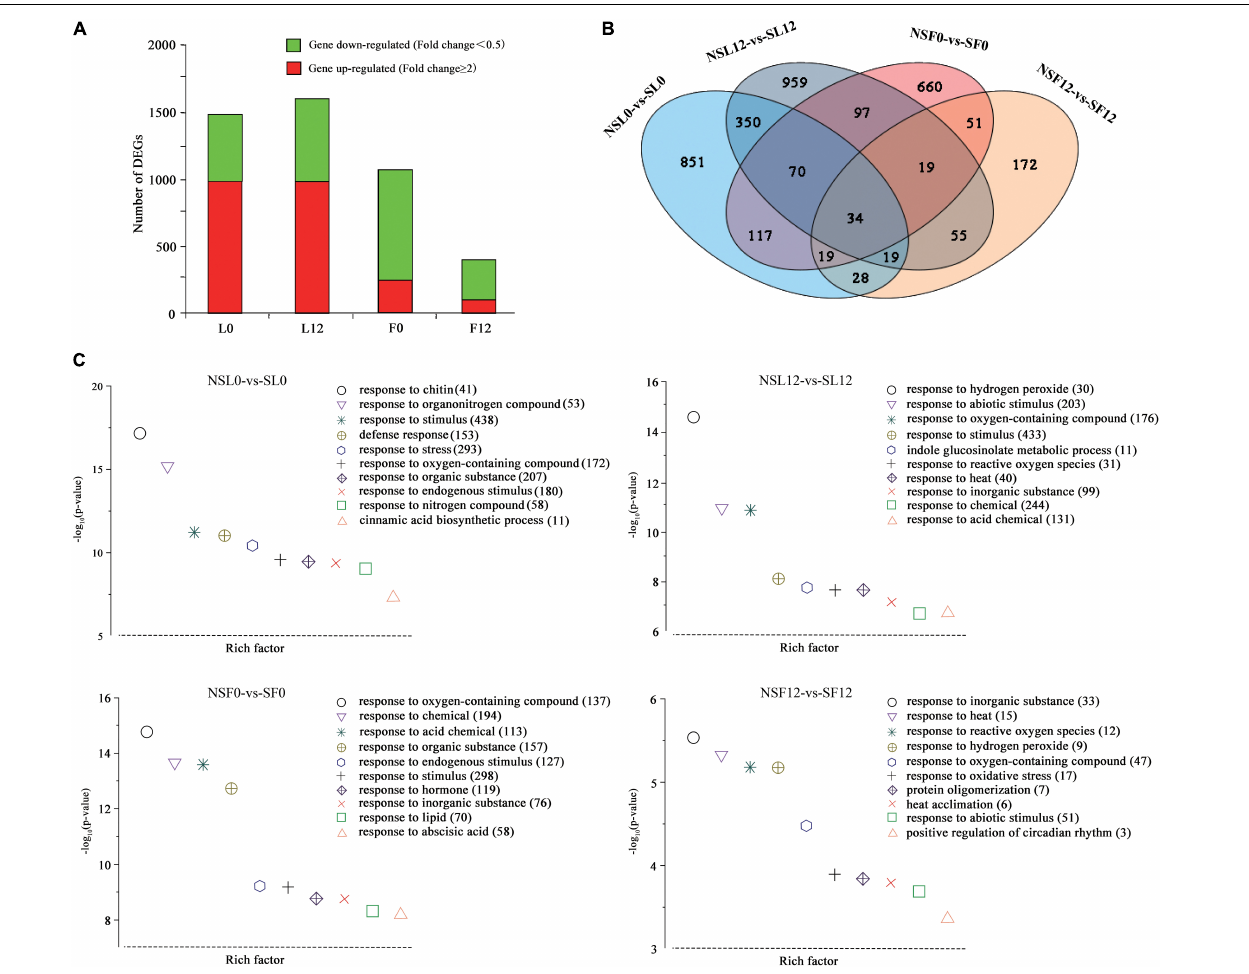
FIGURE 3 | Overview of cucumber transcriptome responses to S fumigation. (A) The number of individual transcripts significantly upregulated or downregulated at L0, L12, F0, and F12. (B) Venn diagram illustrating the number of differentially expressed genes (DEGs) upregulated or downregulated by S fumigation at L0, L12, F0, and F12. (C) Gene ontology (GO) enrichment analysis of DEGs in the cucumber transcriptome at L0, L12, F0, and F12. Data were visualized using a scatter diagram with P -value levels indicated by − log10 ( P -value) and an enrichment factor indicative of individual terms. Values in parentheses represent the number of DEGs in each